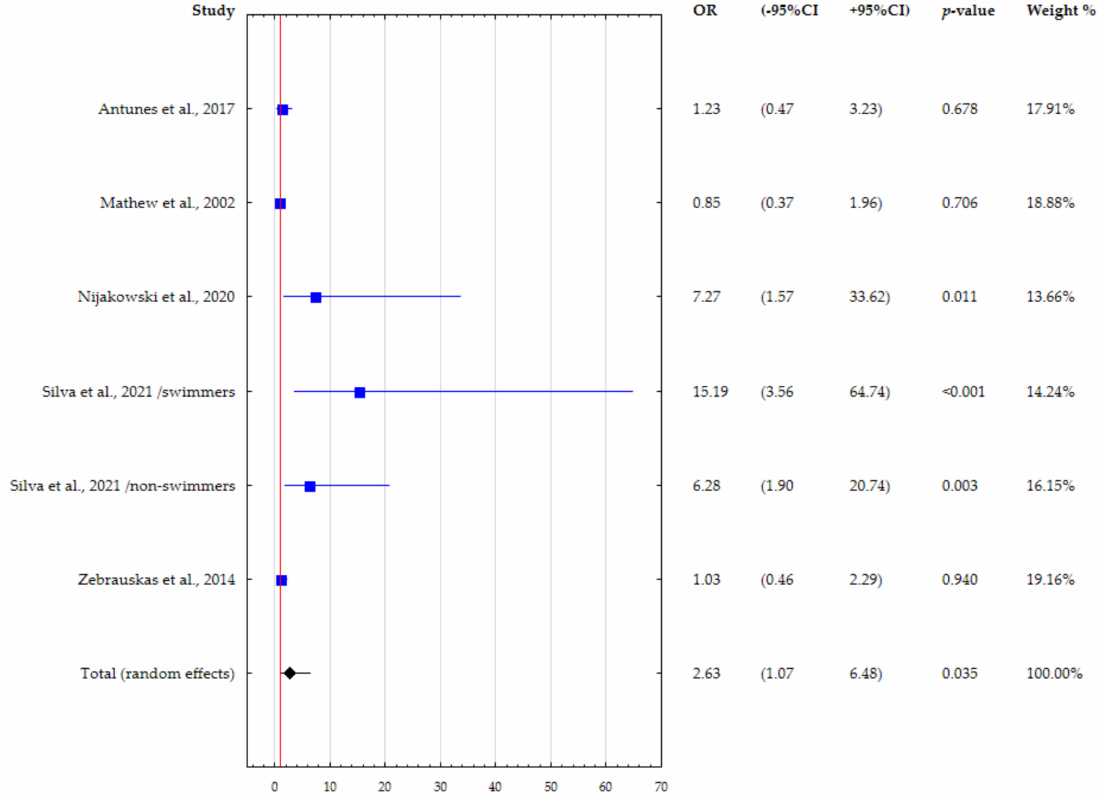
Figure 5. Forest plot presenting the odds for erosive lesions considering sports drink consumption among physically active individuals (OR—odds ratio, CI—confidential